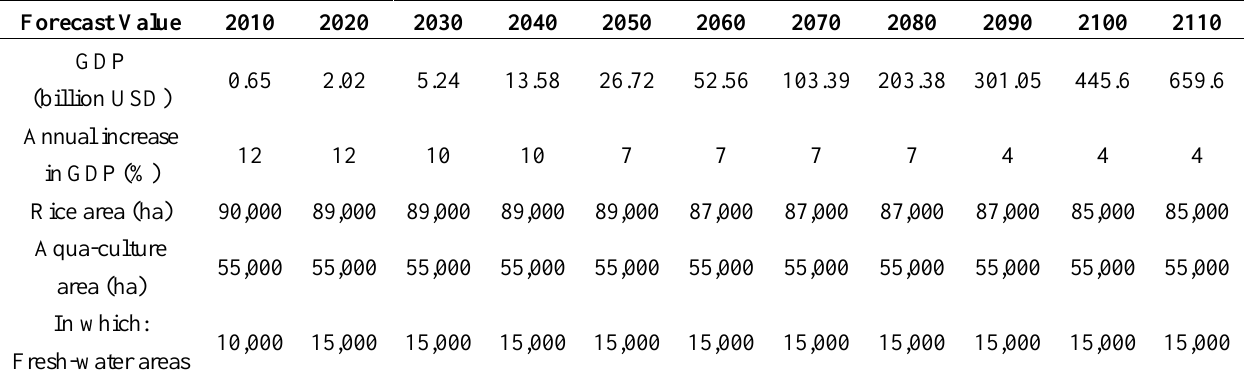
Table A5. GDP forecasts of GDP values and rice and aquaculture areas,